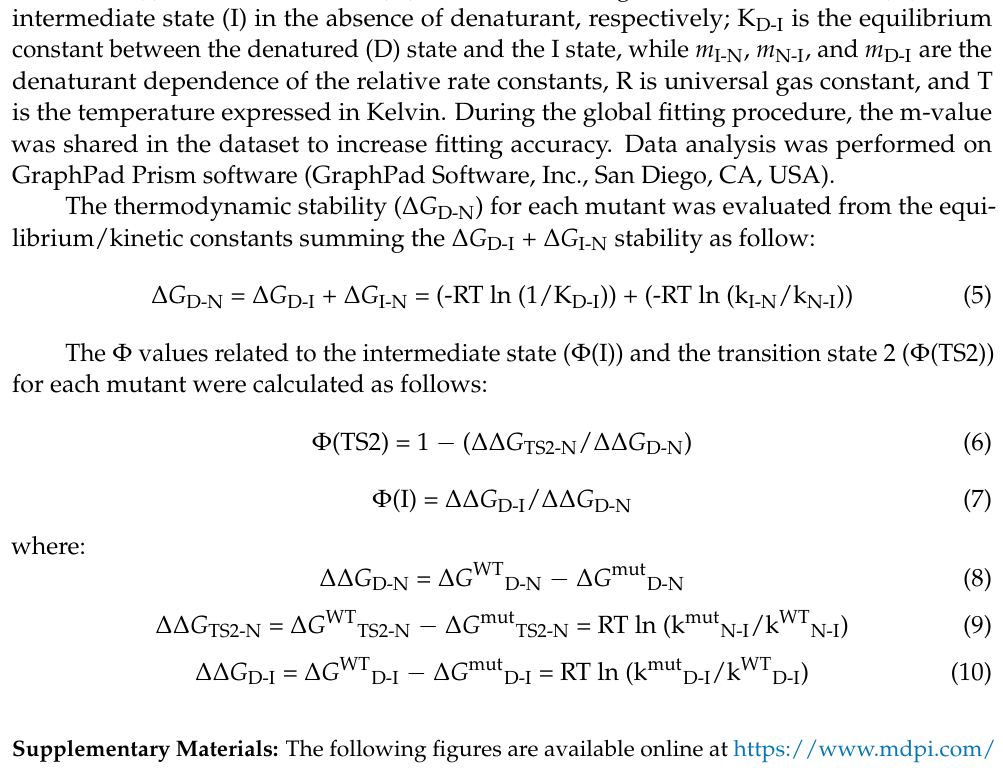
type and mutants. Figure S2: Representative kinetic traces of BRD2(2) A367G mutant for unfolding ( a ) ([Urea] = 8.1 M) and refolding ( b ) ([Urea] = 0.7 M) together with their relative residuals